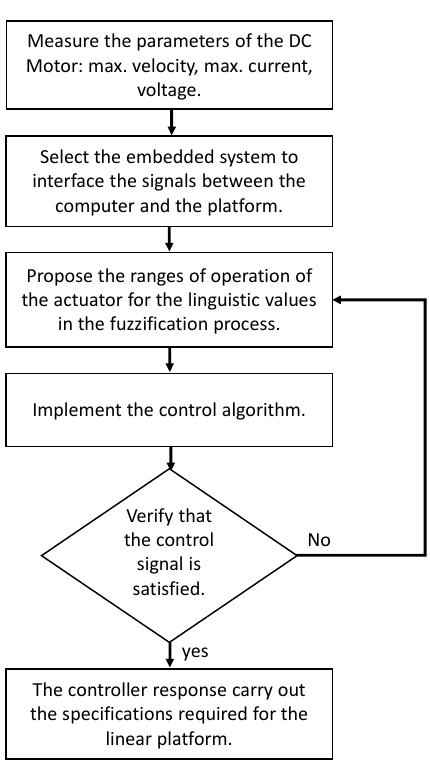
Figure 7. Steps to design the